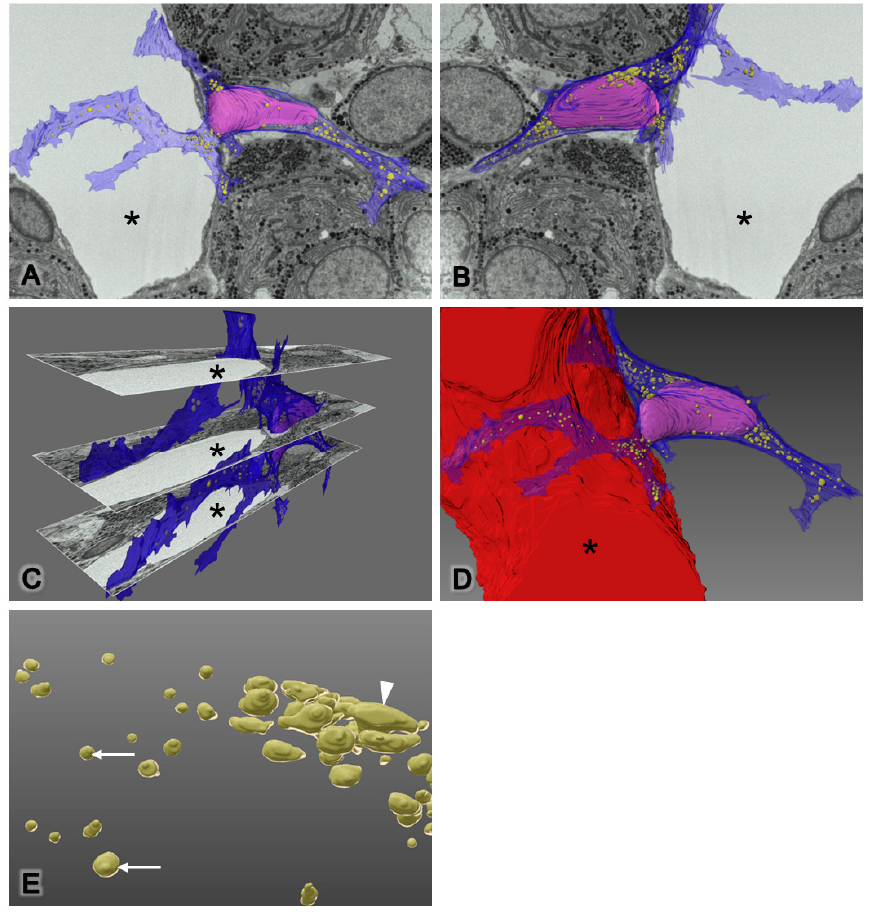
Figure 6. Three-dimensional reconstruction of novel desmin-immunopositive perivascular cells: anterior ( A ), posterior ( B ), and luminal diagonal views ( C ). Three-dimensional diagram shows the relationship between DIP cell and capillary ( D ). The globular and anastomotic rER appearances are white arrows and white arrowhead, respectively ( E ). Capillaries are asterisks, pseudocolor of cytoplasm is blue, pseudocolor of nucleus is pink, and pseudocolor of rER bodies are yellow, magnification is 2800 × , image pixel size on the XY plane is 19.937 nm, and resolution on the Z plane is 60